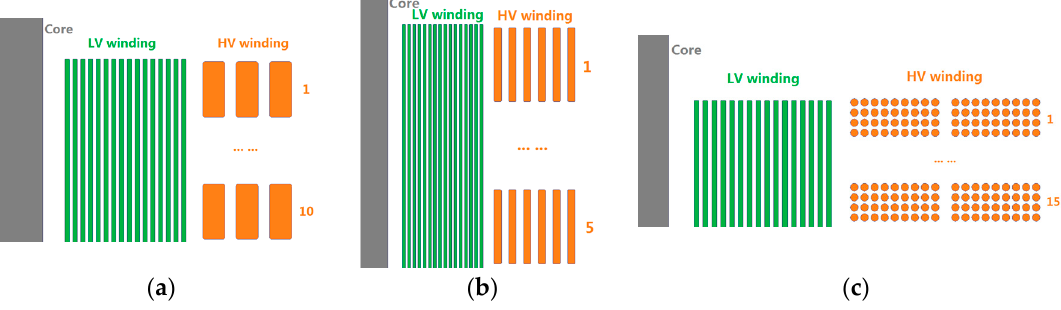
Figure 3. Winding arrangements for different windings: ( a ) N-1; ( b ) N-2; ( c ) N-3.